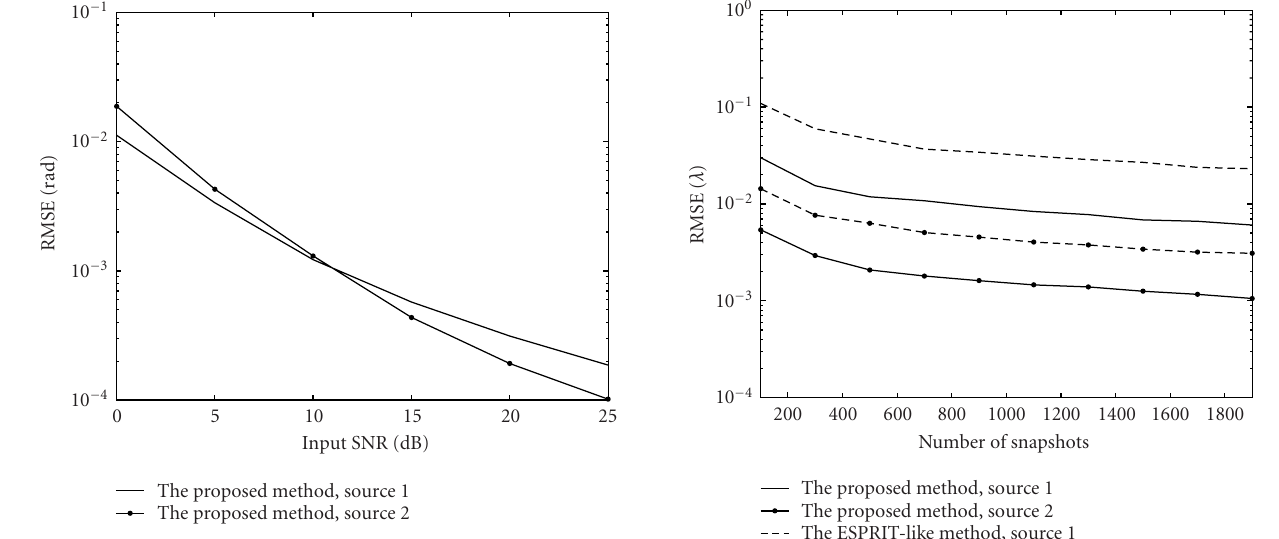
Figure 4: The RMSE of the estimated frequency over 500 Monte Carlo runs versus the input SNR; 14 sensors and 1000 snapshots are used and the two equi-power sources approach the array from 38 ◦ and 20 ◦ , respectively.